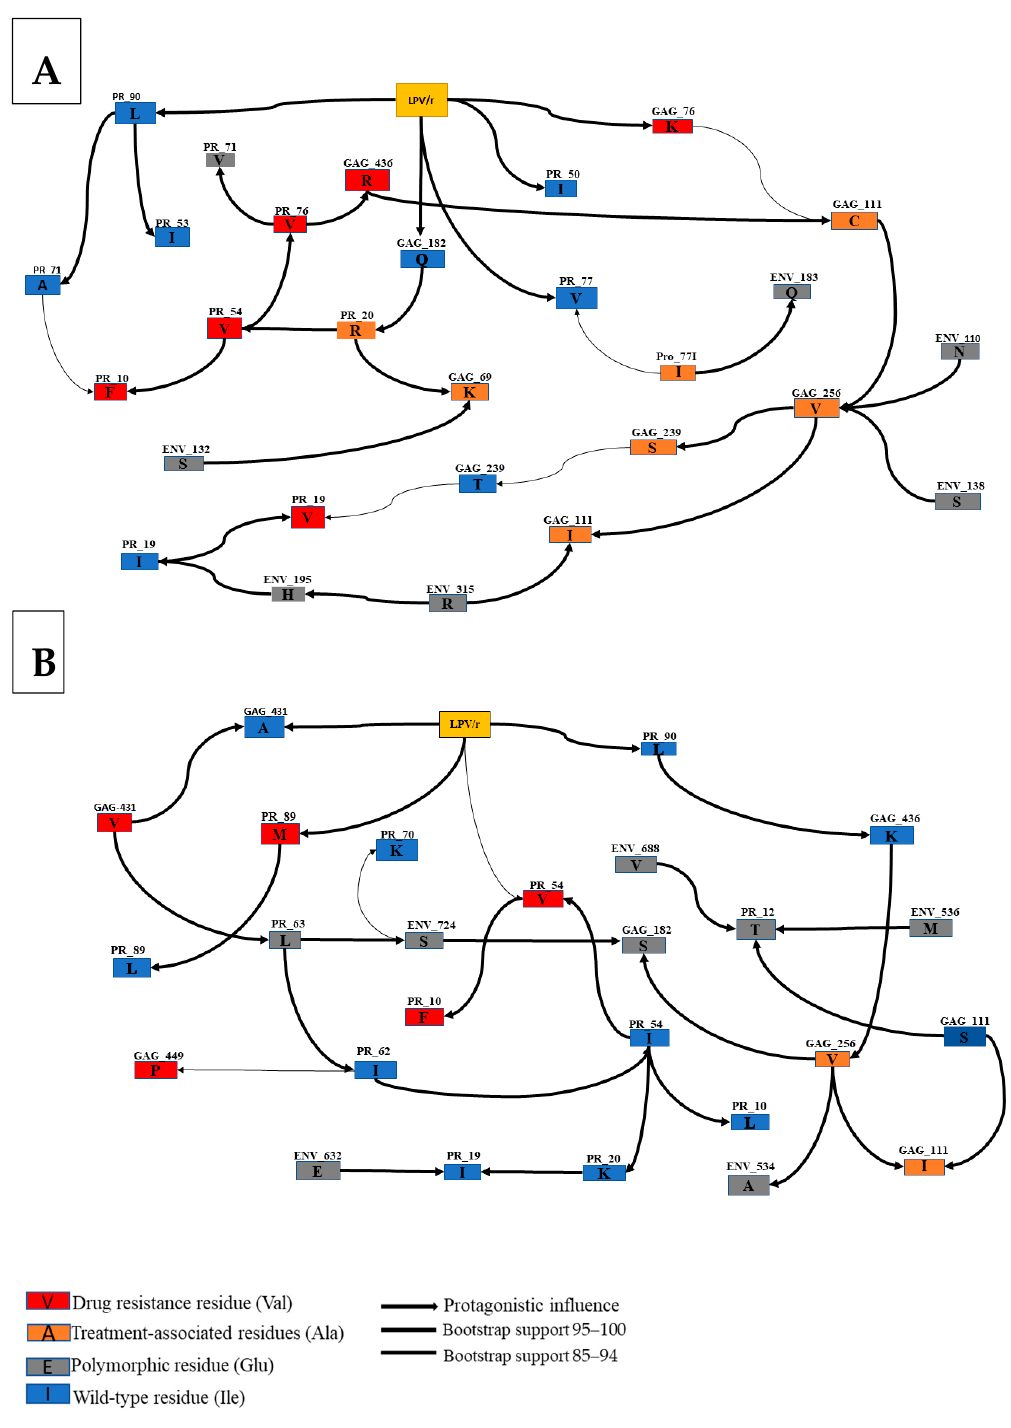
Figure 3. Annotated Bayesian network based on 5000 bootstraps, showing the association between nodes indicating Env and Gag mutations in subtype C LPV/r-treated sequences. Here, we determined the association between ( A ) Env Gp120, Gag, PR mutations, and treatment experience and ( B ) Gp41, Gag, PR, and treatment experience. The color code of nodes is defined based on their link with LPV/r: drug resistance variants (red), treatment associated variants (orange) and natural occurring: Polymorphic variants (gray), wild-type variants (blue). The arcs represent a direct dependency between corresponding nodes, and the thickness of an arc is in proportion to bootstrap support. The arc direction does not represent the accumulation of mutations or causal meaning but may indicate a multivariable effect in the network.